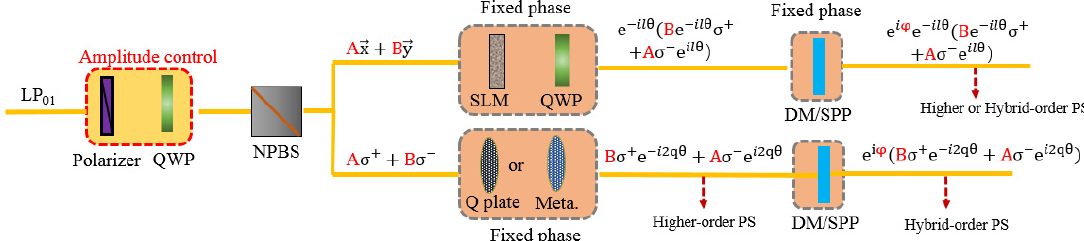
Figure 7. The flow chart of tunable OAM generation by interfering with two Laguerre-Gaussian modes. Adjusting phase and amplitude factors of two branches by ( a ) optical elements and ( b ) a HWP and a SLM.